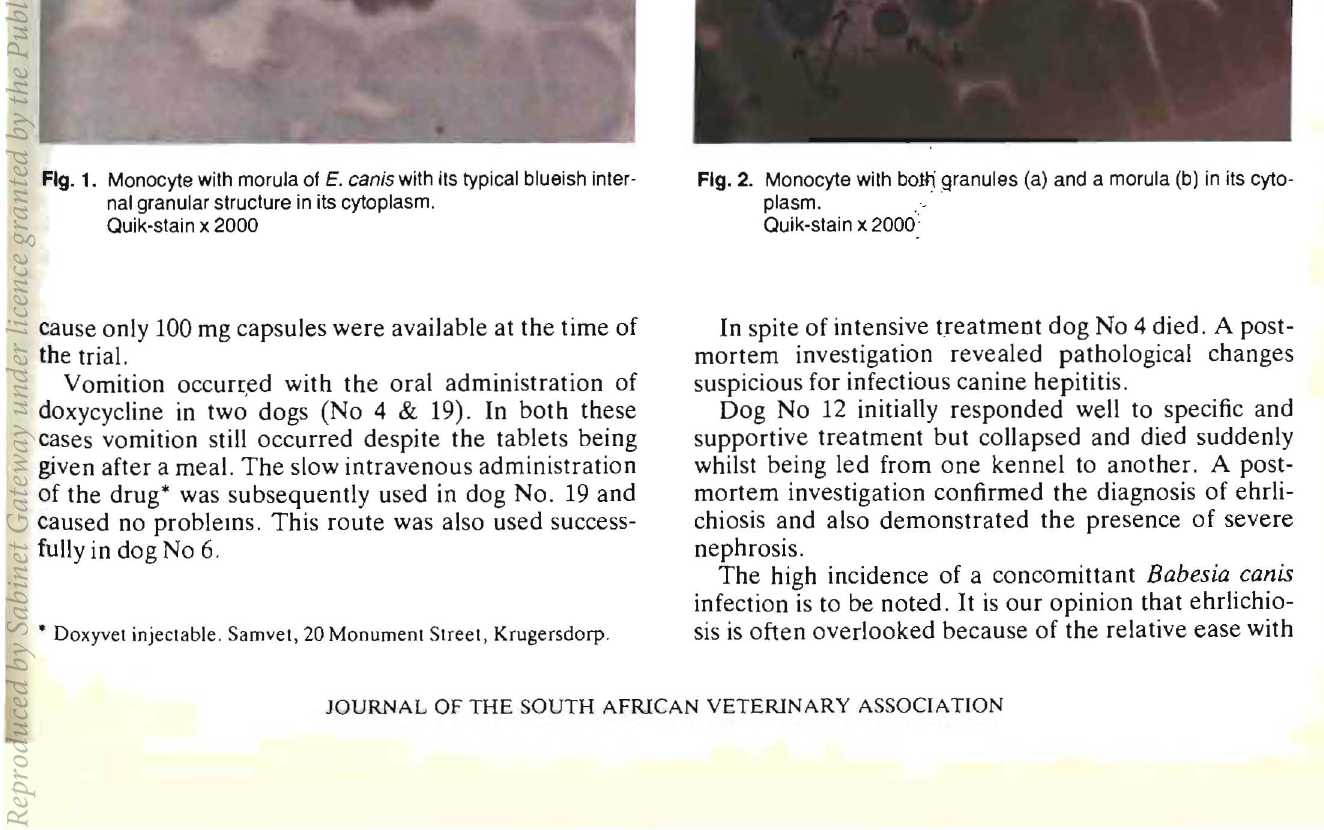
Fig. 2. Monocyte with bolti granules (a) and a morula (b) in its cyto- plasm. . . . Quik-stain x